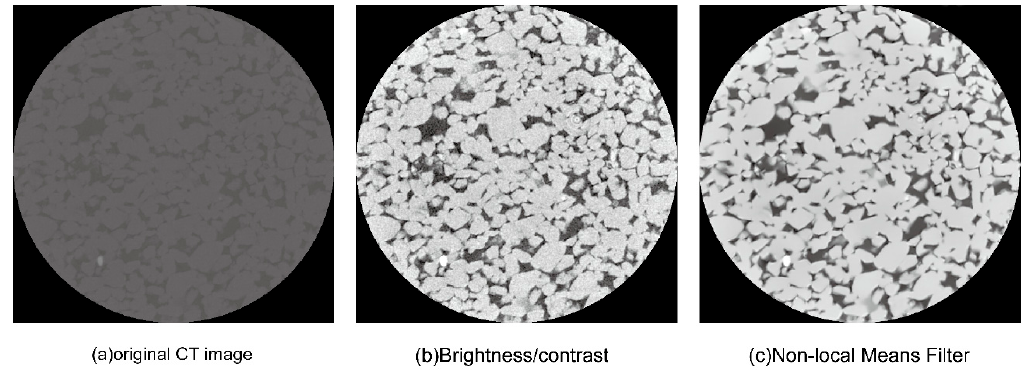
Figure 1. ( a ) Original computed tomography (CT) image; ( b ) image with brightness / contrast filter; ( c ) noise-removed image by non-local means